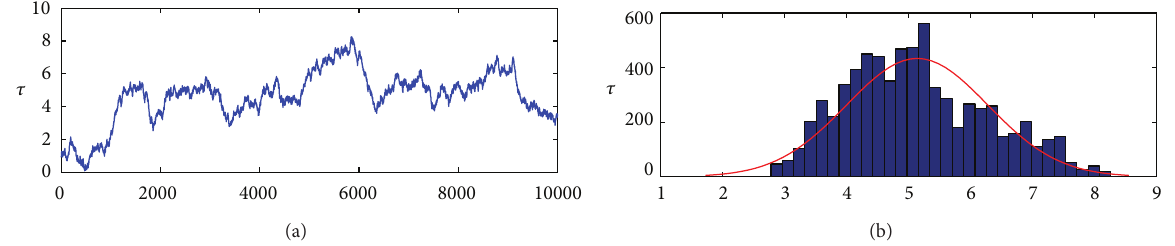
Figure2:MCMCanalysisofparameter 𝜏 basedon(6),(22),andtheexperimentaldatain[13].(a)istherandomseries,and(b)isitshistogram. The algorithm ran for 10 4 iterations with a burn-in of 3000 iterations. The initial conditions were 𝜏 = 0.9 .